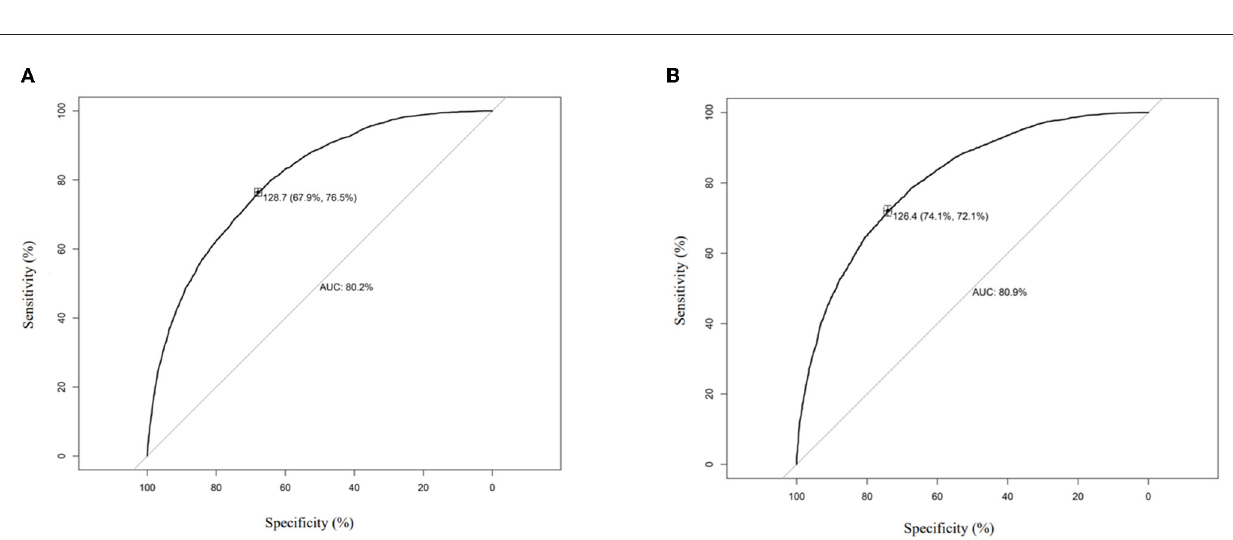
9.1 ± 4.8 in this study. However, in our study, the average of SOFA was 5.04 ± 3.35. It may be the reason why the mortality in our study is lower. The other study based on MIMIC-IV reported 17.62% of patients with SAE died in 30 days which was comparable with our results